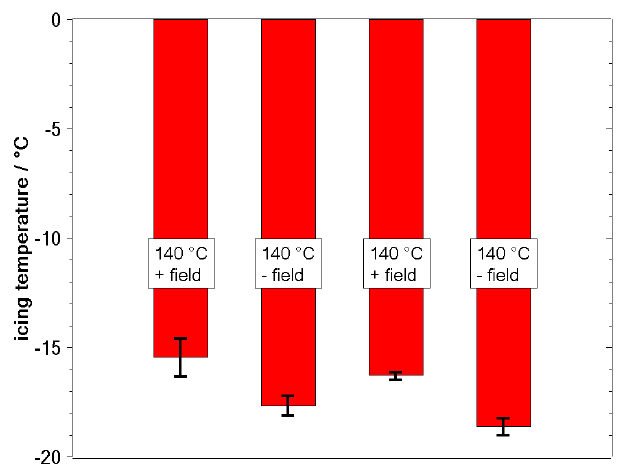
Figure 8. Reversibly-tunable freezing temperature on P(VDF-TrFE)-coated glass after several thermal treatment cycles at 140 °C with alternating direction of the electric